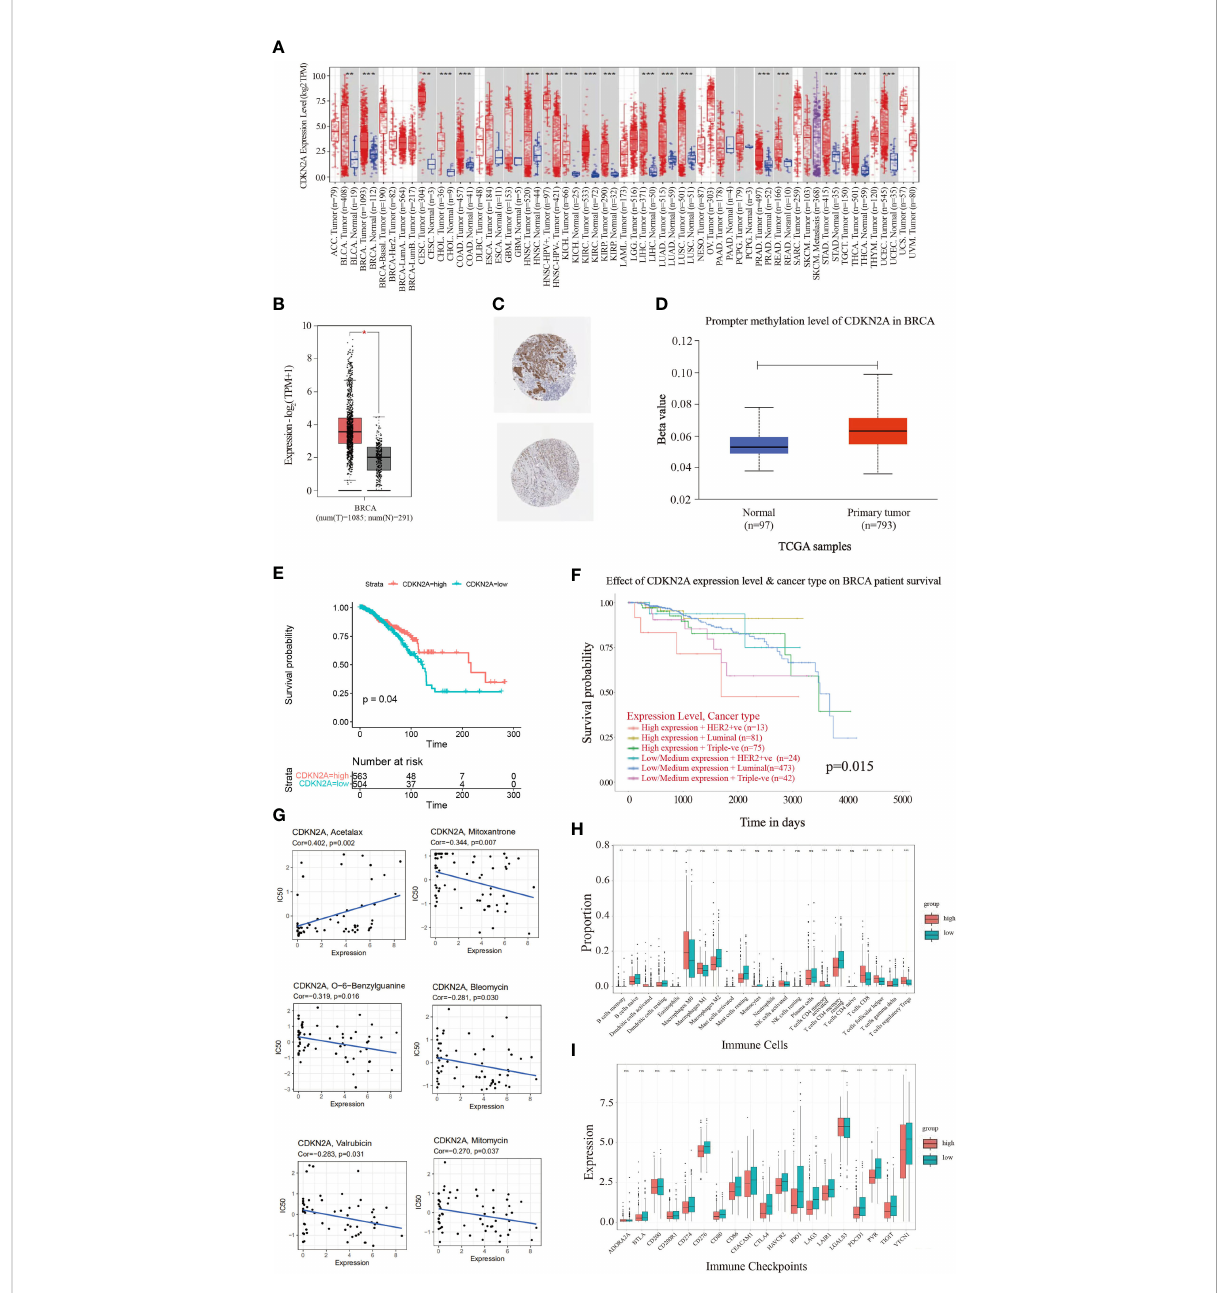
FIGURE 2 The landscape analysis of overexpressed CDKN2A in BRCA. (A) The difference in expression of CDKN2A between various malignant cancer types from the cancer genome map (TCGA) database across TIMER database. CDKN2A was upregulated in bladder urothelial Carcinoma (BLCA), breast invasive carcinoma (BRCA), cervical squamous cell carcinoma and endocervical adenocarcinoma (CESC), cholangiocarcinoma (CHOL), colon adenocarcinoma (COAD), head and neck squamous cell carcinoma (HNSC), kidney chromophobe (KICH), kidney renal clear cell carcinoma (KIRC), kidney renal papillary cell carcinoma (KIRP), liver hepatocellular carcinoma (LIHC), lung adenocarcinoma (LUAD), lung squamous cell carcinoma (LUSC), Prostate adenocarcinoma (PRAD), Rectum adenocarcinoma (PEAD), Stomach adenocarcinoma (STAD), Thyroid carcinoma (THCA) and Uterine Corpus Endometrial Carcinoma (UCEC). (*P < 0.05. **P < 0.01. ***P < 0.001). (B) CDKN2A was signi fi cantly upregulated in BRCA by GEPIA database. (C) Representative immunohistochemical images of CDKN2A in BRCA tissues. (D) Promoter methylation levels of CDKN2A in normal tissues and primary BRCA tissues in the UALCAN database. (E) The Kaplan-Meier curves of OS for low and high expression of BRCA patients. (F) The prognostic values of CDKN2A in different BRCA subtypes. (G) Scatter plots depict the relationship between CDKN2A expression and drug sensitivity in BRCA. (H) Comparison of in fi ltration of immune cells between high and low CDKN2A expression groups in BRCA. (I) Comparison of immune checkpoints expression between high and low CDKN2A expression groups in BRCA. The P values of the fi gure are shown as follows: *P < 0.05. **P < 0.01. ***P < 0.001. ns (not signi fi ciant, P >